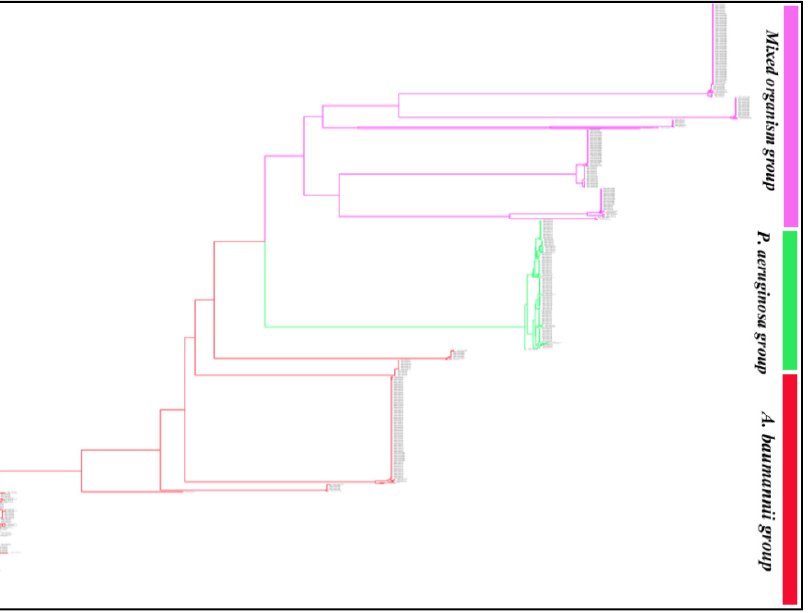
Figure 1. Phylogram of the 929 blaOXA sequences of Klebsiella pneumoniae , Acinetobacter baumannii , Pseudomonas aeruginosa , and Enterobacter spp. The 929 sequences formed three main clusters with 927 leaves and 1856 nodes. The tree session is also shared for a broader view (https://phylogeny.io/share/08bcde3be7fa2fb9c87e77fff2968967b5fa0f3d, accessed on 15 September 2021). In the shared tree session, the zoom in and out, scrolling (up, down, left and right) option is available which can be used to discern the interest of branches and clades of each enzyme group and their